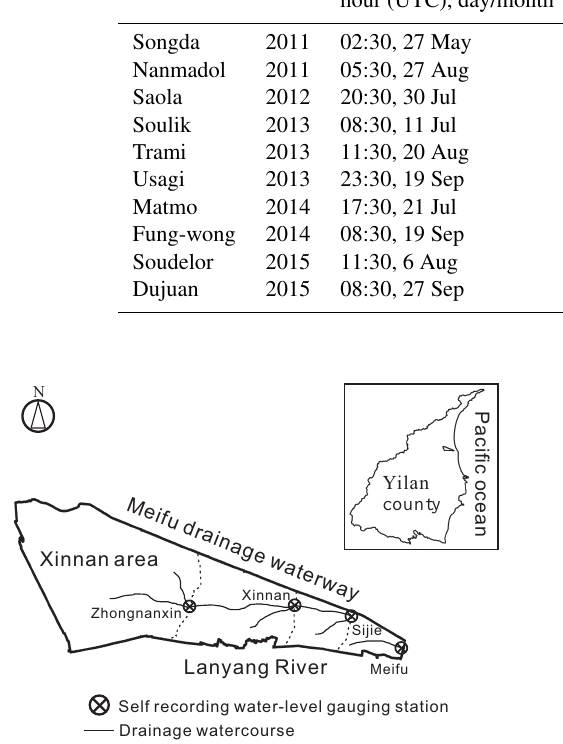
Table 2. Historical typhoon events recorded by SNTIX. Typhoon Year Time of official typhoon Affecting Cumulative Maximum rainfall sea warning issued: